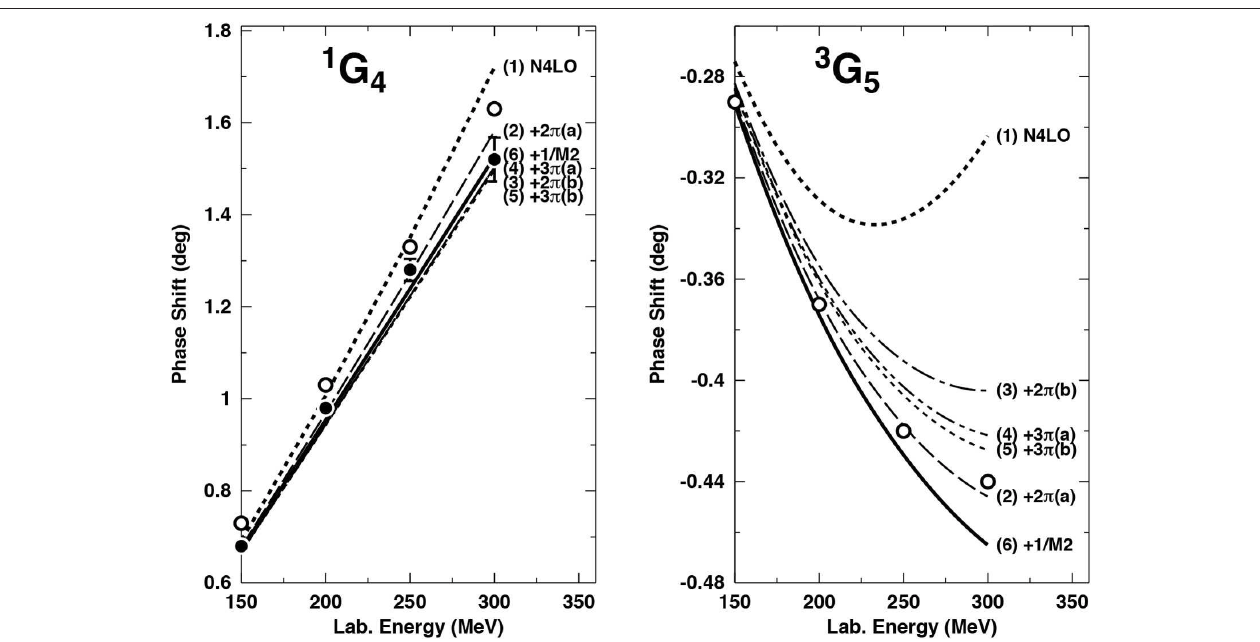
FIGURE 12 | Effect of individual N 5 LO contributions to the neutron-proton phase-shifts of two G waves. Contributions are added up successively starting from the N 4 LO result (1) to the final N 5 LO result (6). A SFR cutoff ˜ 3 800 MeV is used. The filled and open circles represent the results from the Nijmegen multienergy np = phase-shift analysis [ 93] and the GWU np analysis SP07 [94], respectively. Reprinted figure with permission from Entem et al. [48], copyright (2015) by the American Physical Society.